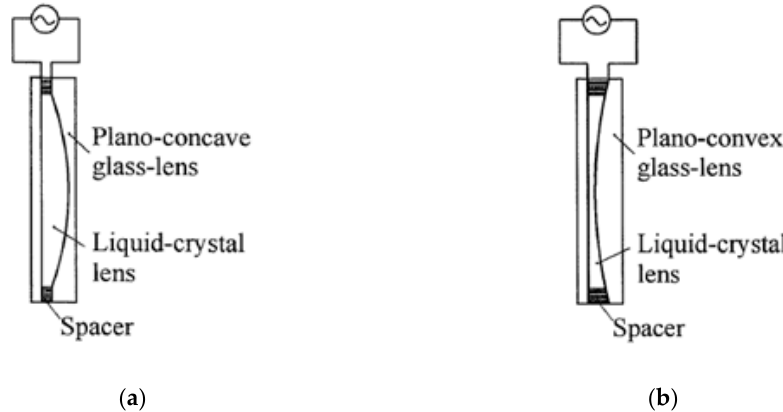
Figure 4. First proposals of liquid crystal (LC) lenses. ( a ) Plano-concave lens (b) Plano-convex lens. Reprinted with permission from [103]. Copyright 1979 IOP Science.